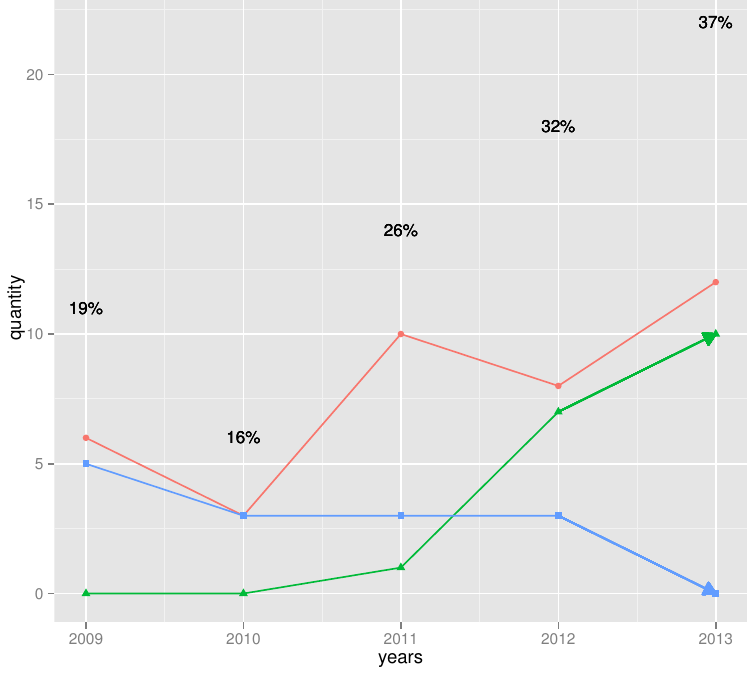
Figure 3. Consumer electronics use within the interval 2009–2013. The percentage numbers reflect the percent of portable devices use compared with the total number of measuring techniques reviewed per